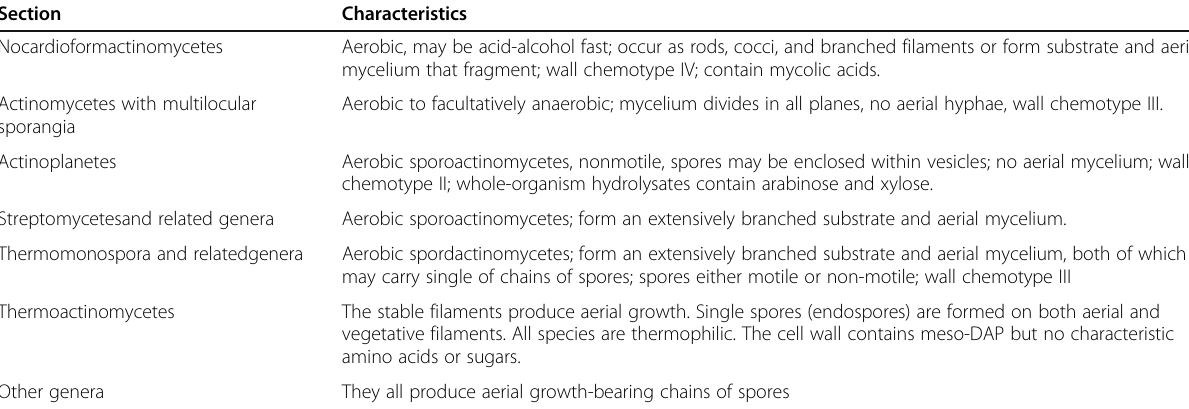
Table 1 Different groups of actinomycetes Section